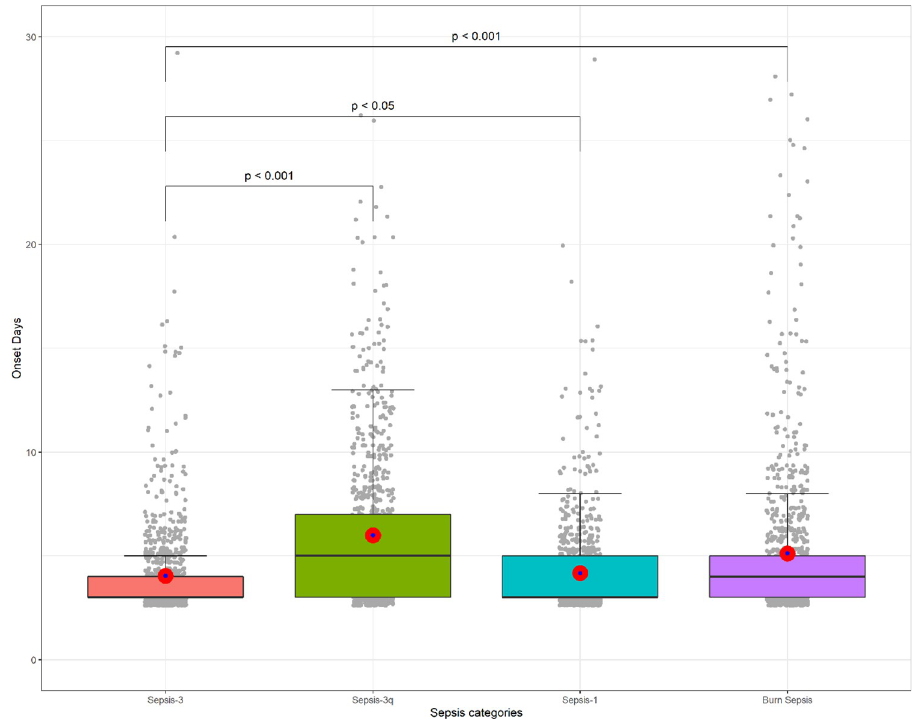
Fig 3. Boxplot of onset days for the four categories of sepsis (gray dots = sample data points, black dots = outlier, blue dots = mean, red dots = 95% confidence interval).